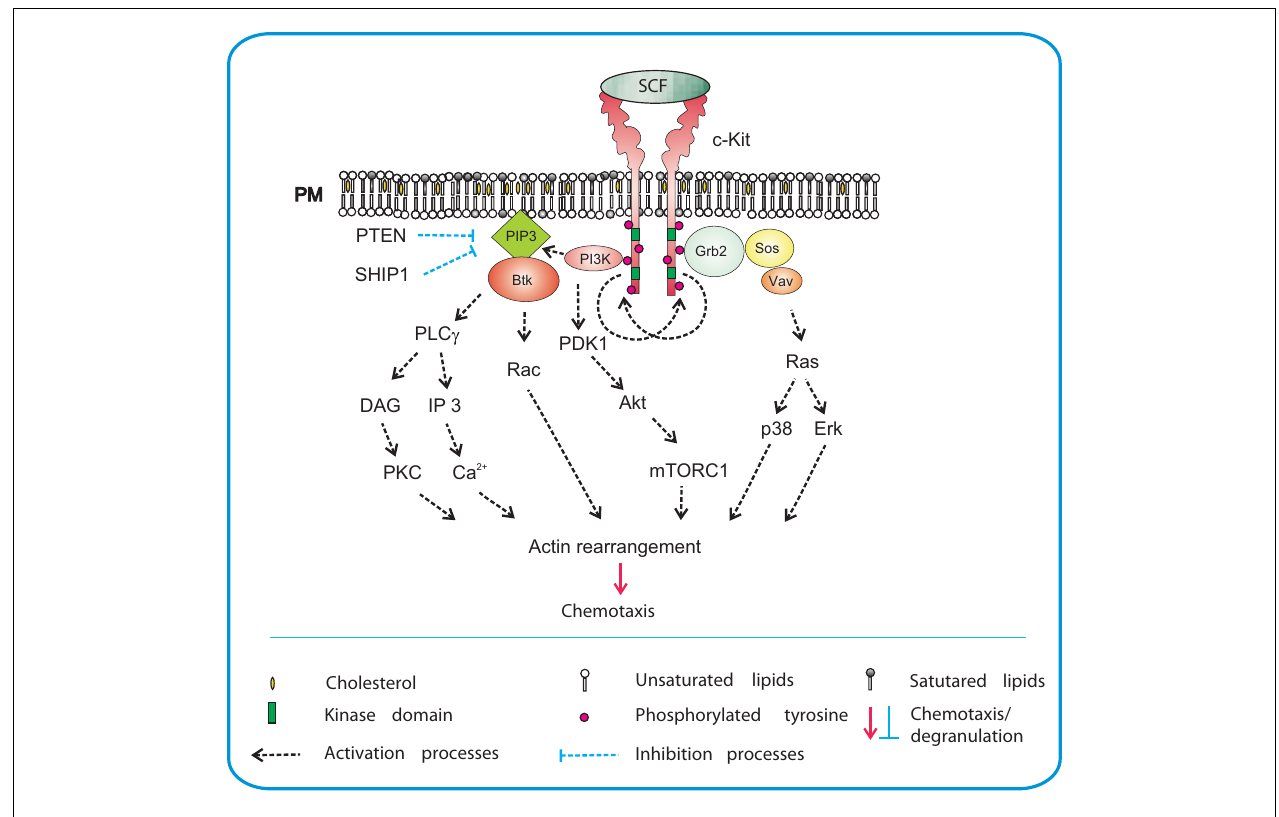
kinase (PDK)-1 and Akt to the plasma membrane and subsequent phosphorylation of Akt by PDK1. Akt directly phosphorylates the negative regulator of mTORC1, inactivating thereby its inhibitory action. PIP3 levels are negatively regulated by phosphatases PTEN and SHIP1. Grb2 orchestrates activation of Ras by recruiting Ras and Rho family GEFs, Sos, andVav. Through Ras, both p38 and Erk are activated and chemotaxis is also promoted in this way. Signaling molecules in bodies are those located at their sites of action and/or bound to the indicated target molecules; other signaling molecules are presented as plain